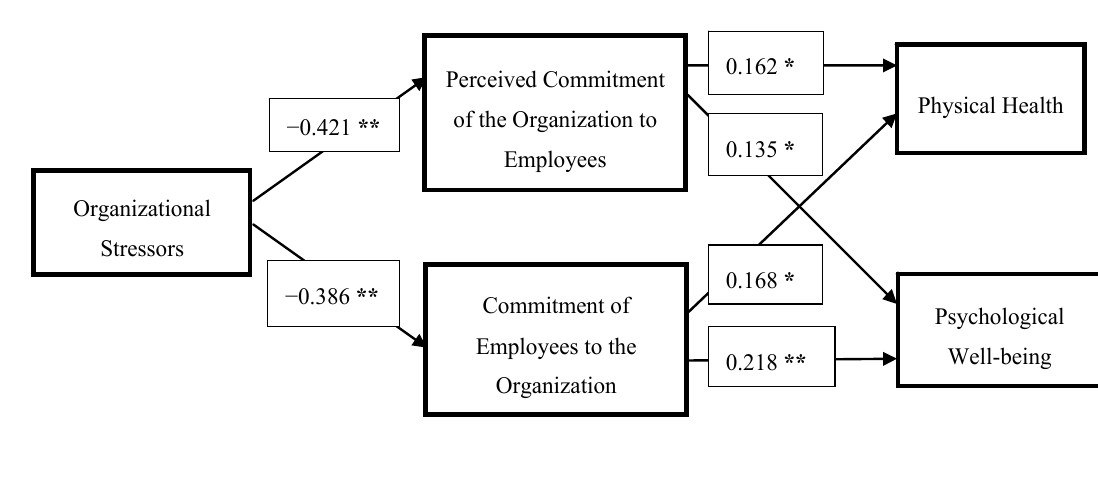
Figure 2. Standardized betas for the mediating impact of commitment ( * p > 0.05; ** p <